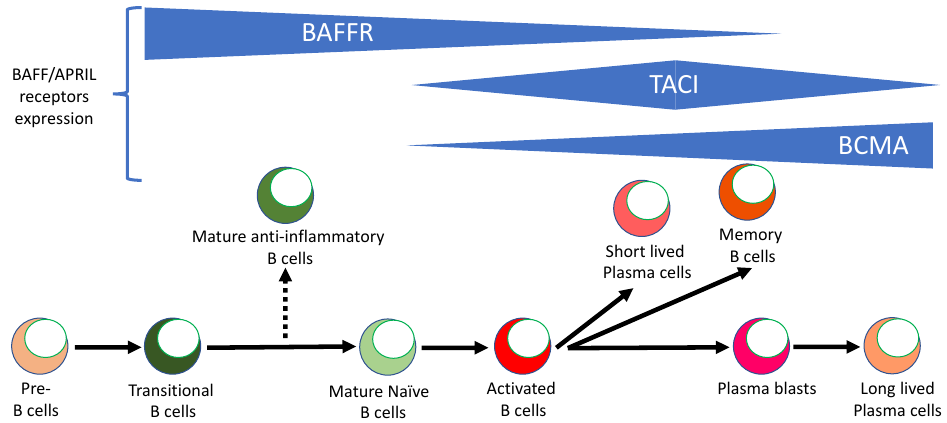
Figure 2. BAFFR, TACI, and BCMA are expressed at different stages of B cell development. After exiting the bone marrow, B cell precursors (pre-B cells) differentiate into immature transitional B cells that have anti-inflammatory functions. Transitional B cells then give rise to mature naïve and mature anti-inflammatory B cell subsets. Mature naïve B cells can become activated and further differentiate into short-lived plasma cells, memory B cells, and plasmablasts, which finally become long-lived plasma cells. All three BAFF and APRIL receptors are expressed at various levels on B cell subsets. BAFFR is highly expressed from the transitional B cells to the mature naïve B-cell stage. TACI is highly expressed from the mature naïve B cells to the activated and memory B cell stages. BCMA is most highly expressed by plasmablasts and short- and long-lived plasma cells.